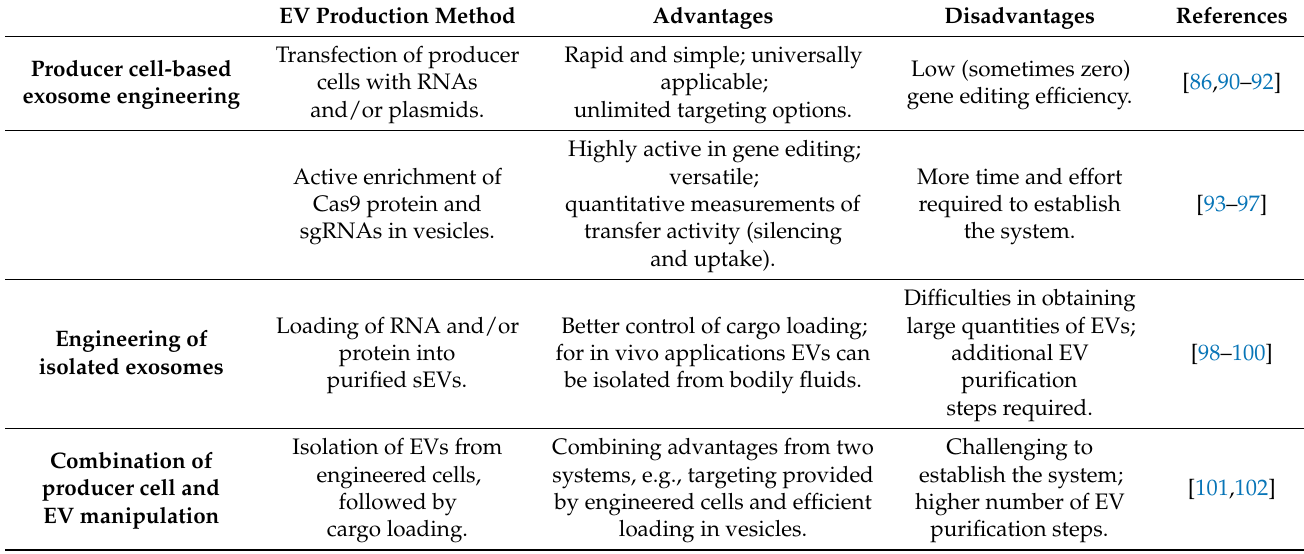
Table 1. Comparison of the various EV production methods used for transfer of CRISPR/Cas9